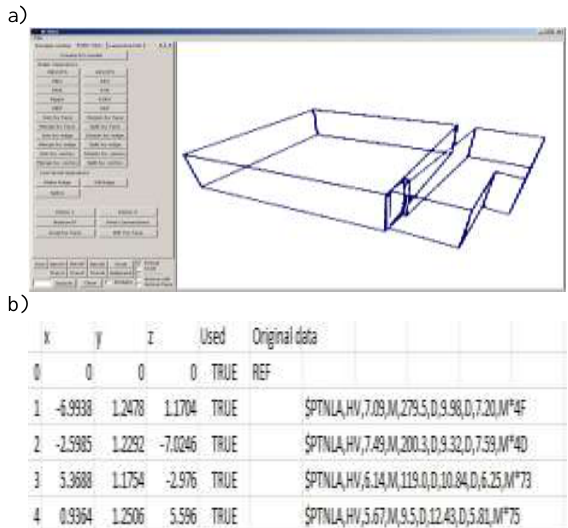
Figure 10. Equipment comparison based on the